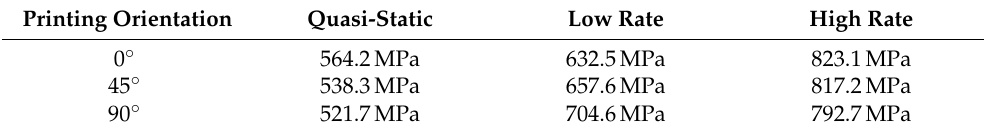
Table 2. Values of the quasi-static and dynamic yield stress R p 1.0 for each printing